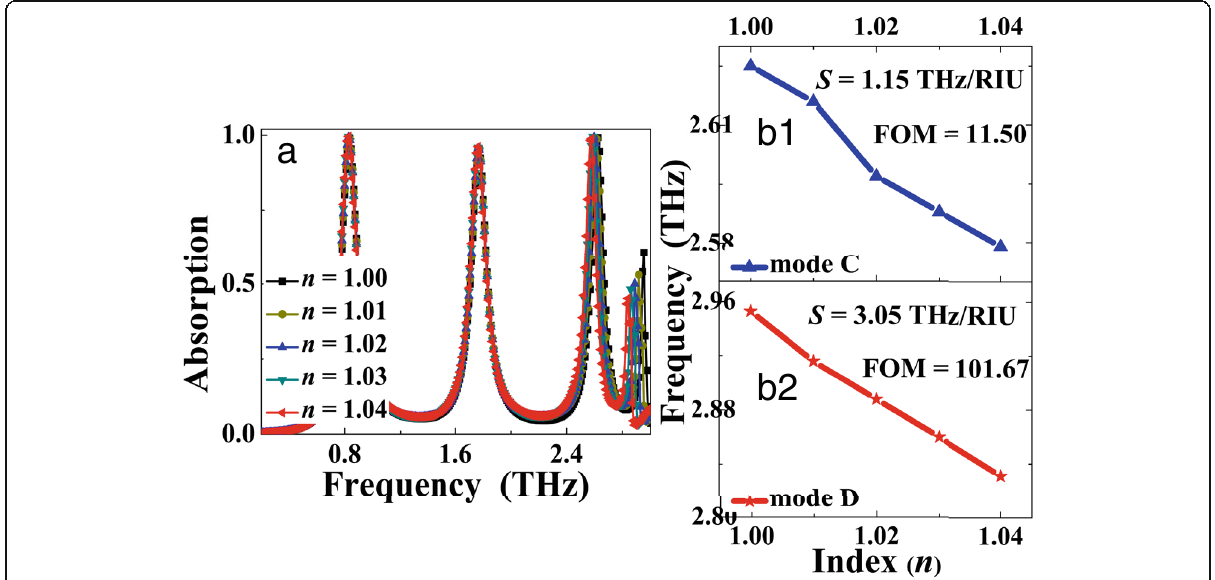
Fig. 5 a shows the dependence of the absorption performance of the quad-band light absorber on the change of the refractive index ( n ) of surroundings. b 1 and b 2 are respectively the resonance frequencies of the modes C and D as the function of the refractive index